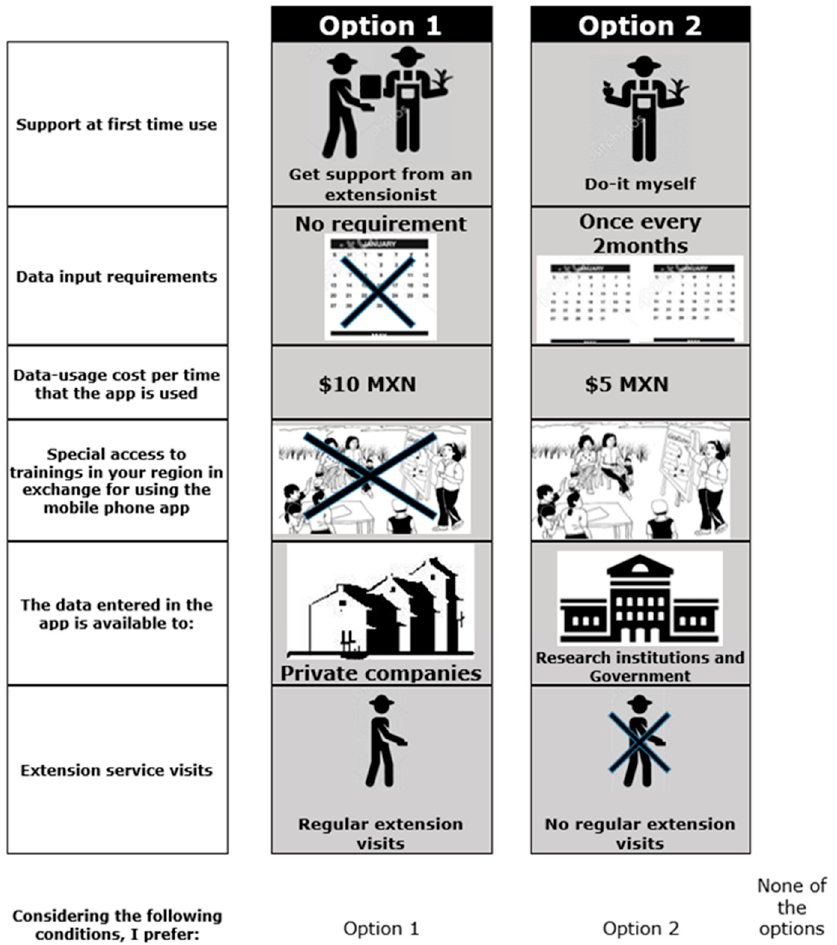
Figure 1. Example of a choice card.